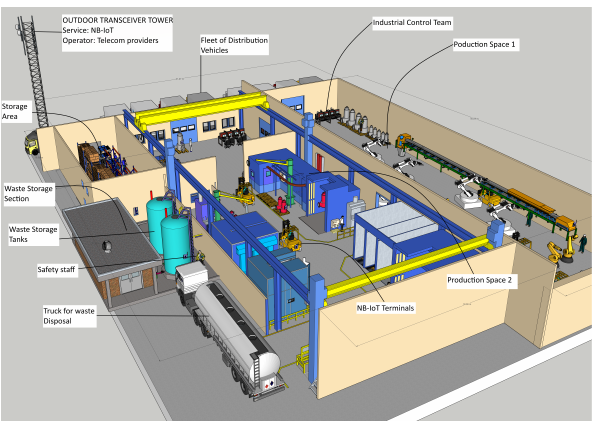
Figure 2. A top overview of the modeled industrial indoor environment. The transceiver tower is positioned outside the